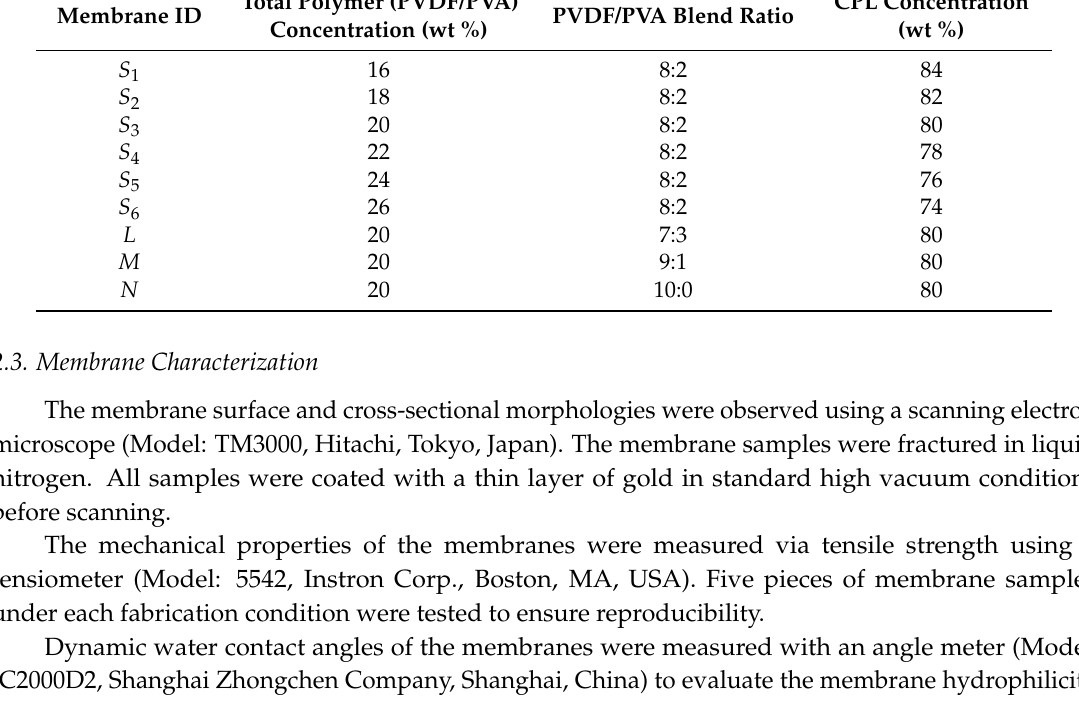
Table 1. Composition of casting solutions for various PVDF/PV blend membranes. CPL, ε -caprolactam. Membrane